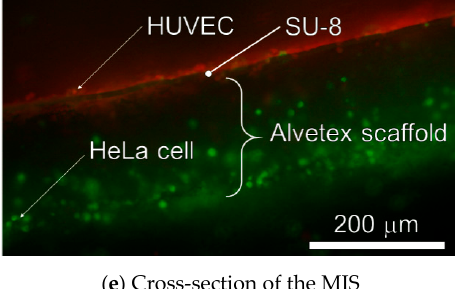
Figure 8. Fluorescence images of the MIS. HUVECs were observed on the porous membrane using filter set 1 ( a ). No cells were observed on the porous membrane using filter set 2 ( b ). No cells were observed on the Alvetex scaffold using filter set 1 ( c ). HeLa cells were observed on the Alvetex scaffold using filter set 2 ( d ). HUVECs, which were emitting red fluorescence, and HeLa cells, which were emitting green fluorescence, were separated by the porous membrane, made of the SU-8 ( e ).